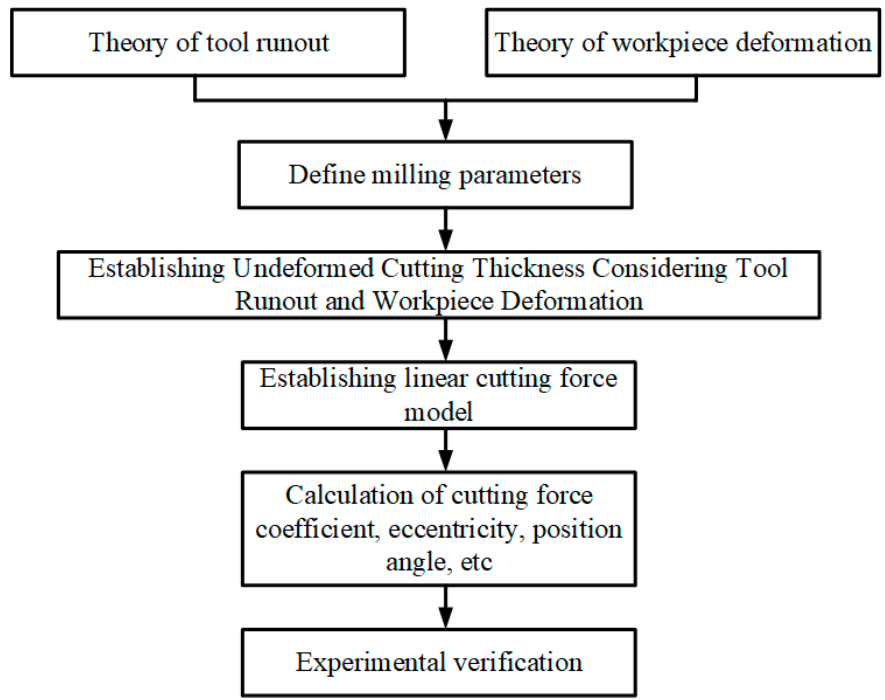
Figure 1. Flowchart of full-text method.